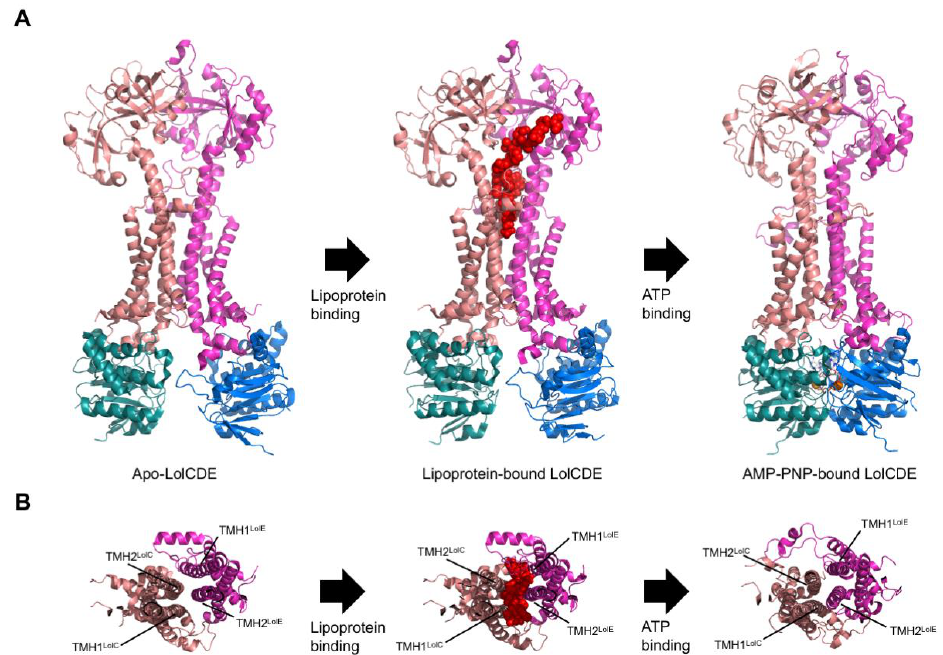
Figure 11. Structures of LolCDE in the Apo (PDB: 7V8M), lipoprotein-bound (PDB: 7V8L), and AMP-PNP-bound (PDB: 7V8I) form. LolC is shown in salmon, LolE is shown in light magenta, one LolD monomer is shown in deep teal, and the other LolD monomer is shown in marine. The lipoprotein is shown in red spheres. ( A ) : Side-view of LolCDE. In the Apo state, LolCDE exhibits a V-shaped cavity that the lipoprotein enters from the membrane. Upon ATP binding (AMP-PNP-bound state), the central cavity is closed, and the substrate is shuffled out of LolCDE to LolA. ( B ) : Cross-sectional view of the TMDs of LolCDE in the different substrate- or nucleotide-bound states. Movement of TMH2 of LolE upon ATP-binding into the central cavity extrudes the substrate out of the transporter.